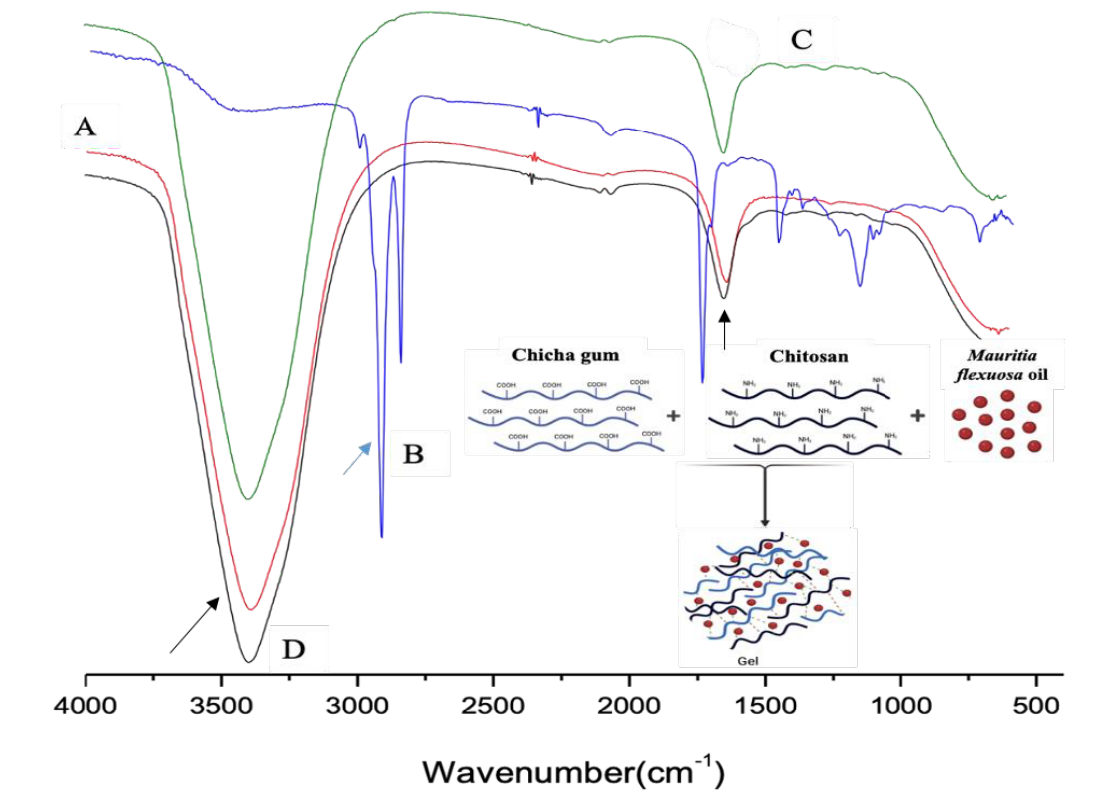
Figure 1. FTIR spectra for (A) chicha gum (CG), (B) Mauritia flexuosa oil, (C) chicha gum/chitosan/ Mauritia flexuosa oil gel (CGCHO), and (D) chitosan-based gel (CHB).